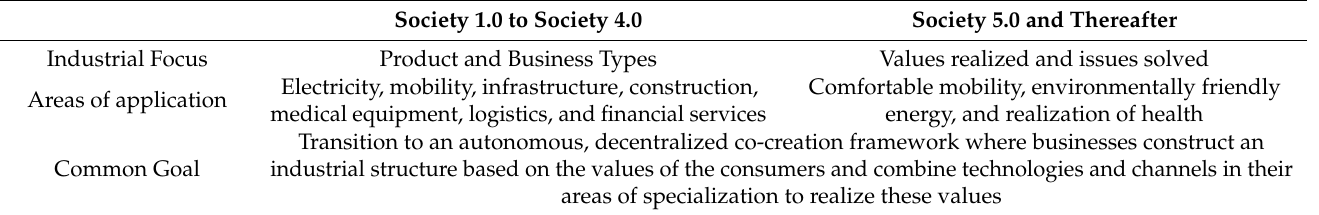
Table 3. Industrial Focus of Societies.